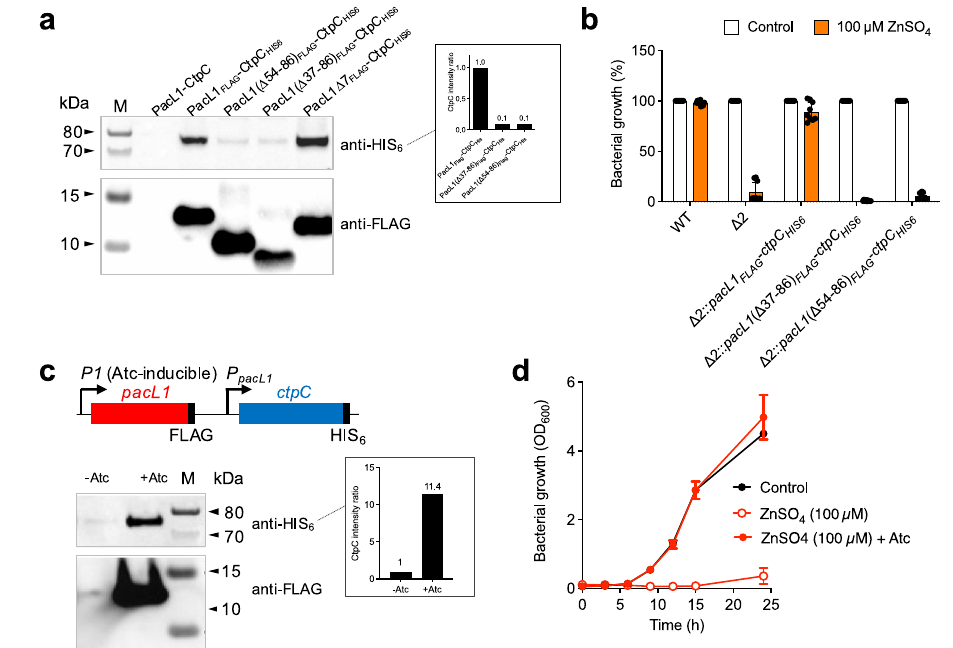
Fig. 5 | PacL1 is required for abundant CtpC levels and resistance to zinc intoxication. a Western-blotting analysis of membrane extracts from M. smeg- matis Δ 2 expressing PacL1 and CtpC, or a combination of HIS 6 -tagged CtpC and FLAG-tagged PacL1, FLAG-tagged PacL1 Δ R 37 S 86 , containing the MBM, FLAG- tagged PacL1 Δ A 54 S 86 , containing the MBM, or FLAG-tagged PacL1 Δ 7, lacking the MBM. All genes are expressed under the control of the native P PacL1 promoter and bacteria were grown in 7H9 medium. The upper membrane was treated for HIS 6 immuno-detectionandthelowermembranewastreatedforFLAGimmuno- detection.Mmolecularsizemarker.RelativeCtpC-HIS 6 proteinquanti fi cationis displayed in the inset. Data show quanti fi cation of one WB (displayed on the left), and are representative of two independent experiments. b Strains used in a were cultivated for 24h in complete 7H9 medium in the absence (Control, white bars) or presence (orange bars) of 100 μ M ZnSO 4 . Bacterial growth was quanti fi ed by turbidity measurement (expressed as % of untreated control).